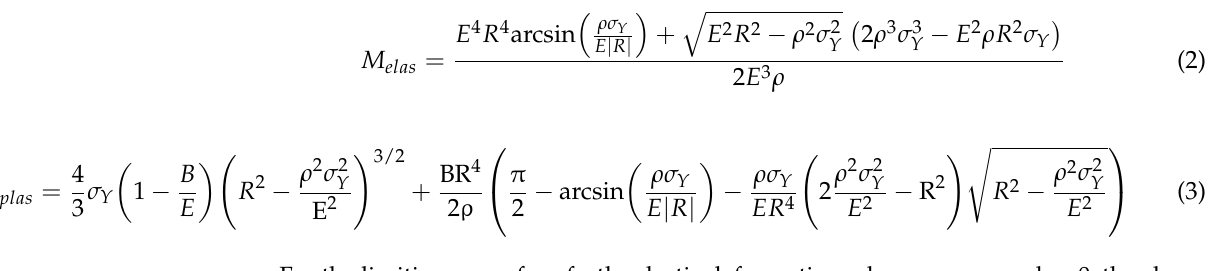
Figure 6. Stress–strain model for SMA wires at different temperatures.